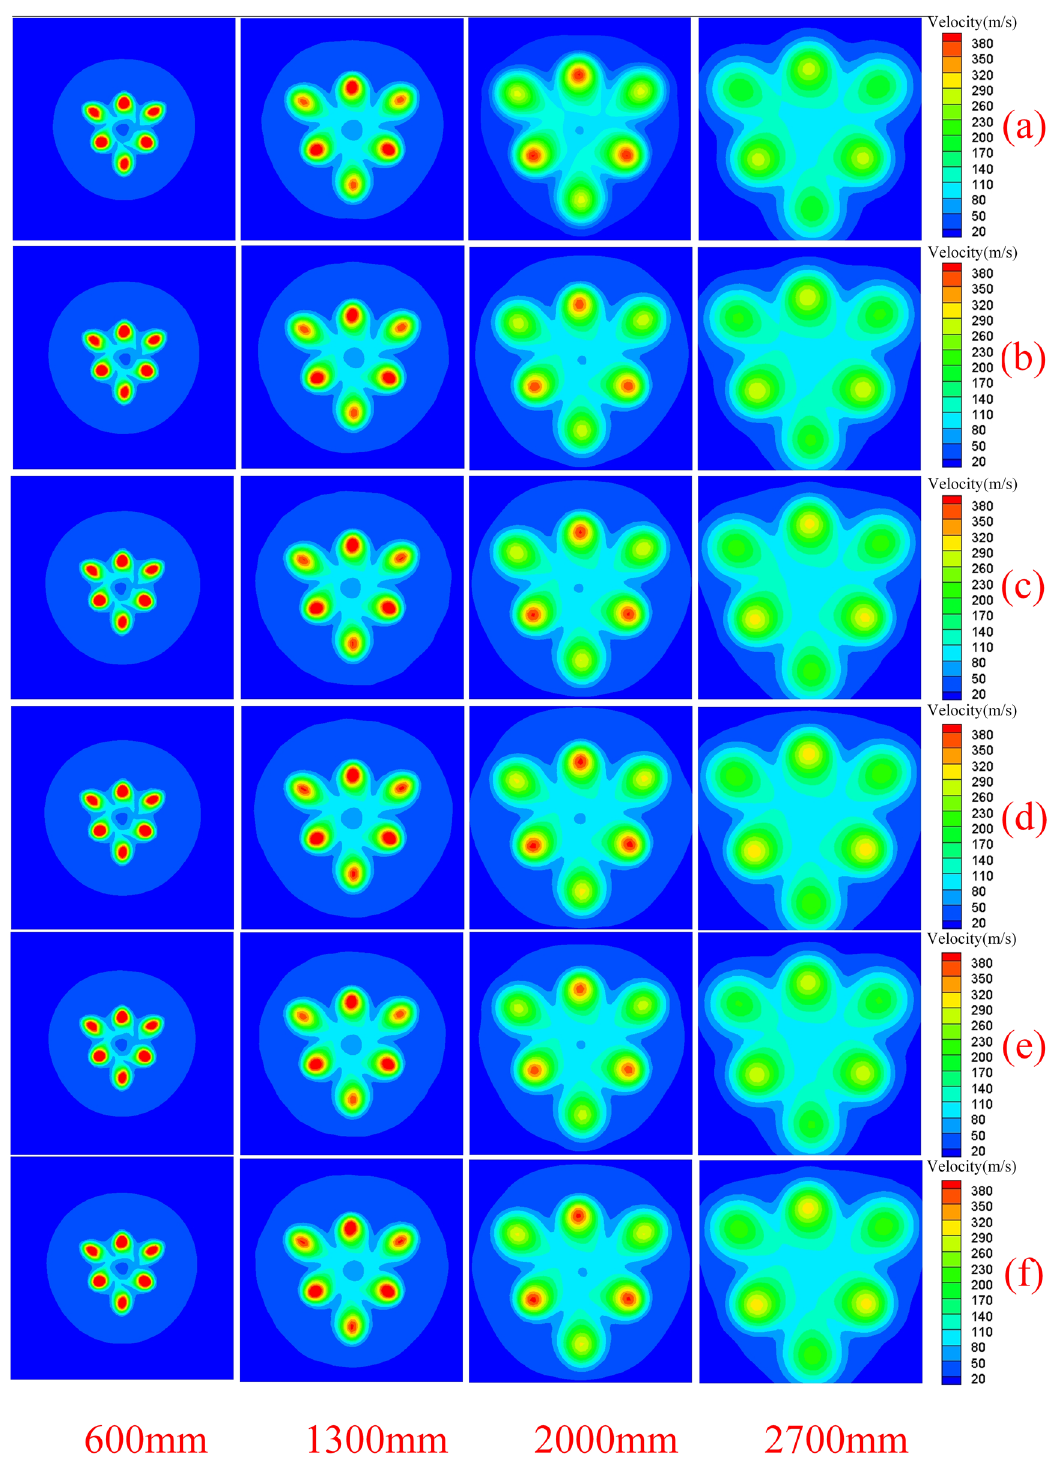
Figure 15: Distribution of the jet velocity fi eld: ( a ) prophase 1,673 K, ( b ) metaphase 1,673 K, ( c ) metaphase 1,823 K, ( d ) metaphase 1,923 K, ( e ) anaphase 1,673 K, and ( f ) anaphase 1,923